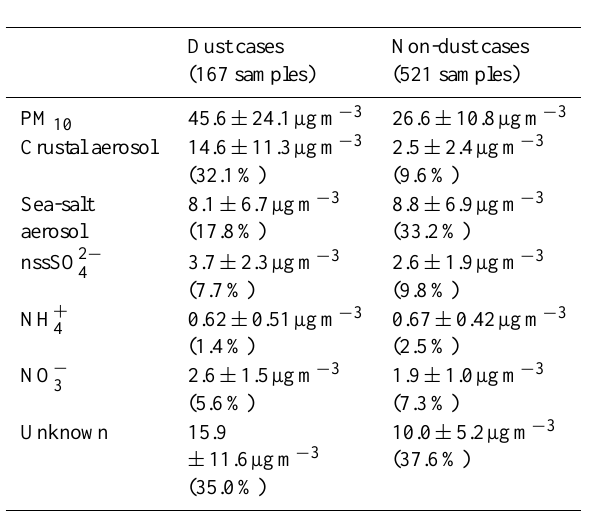
Table 2. Mean concentration and standard deviation of the main component of PM 10 for dust and non-dust cases selected by nssCa concentration (see text). Numbers in brackets are the percentage of the component in the PM 10 .